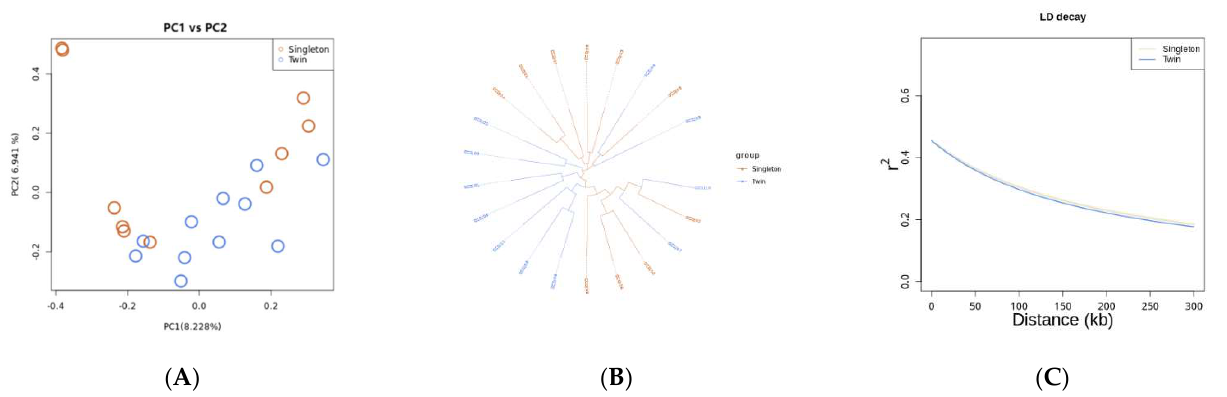
Figure 1. Population genetic diversity. ( A ) PCA plot of Dezhou donkey populations; ( B ) Neighbor- joining phylogenetic tree of Dezhou donkeys; ( C ) Linkage disequilibrium decay analysis.